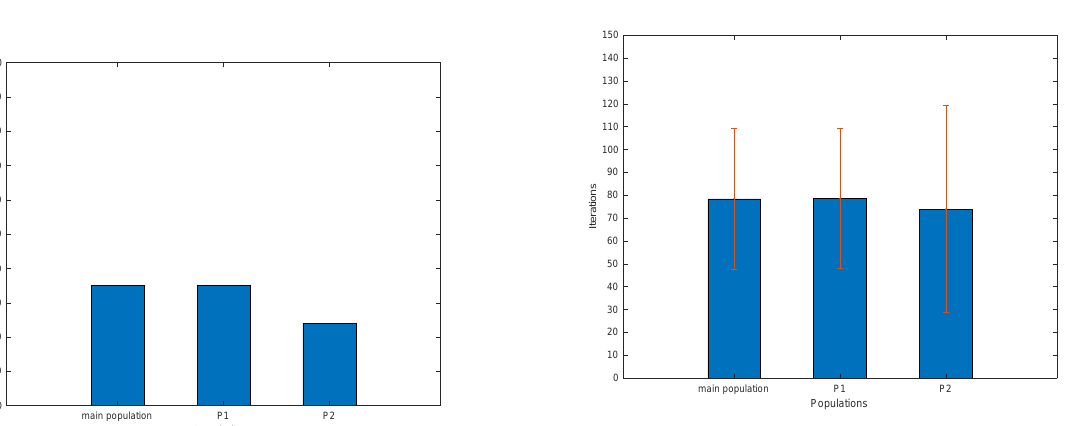
Figure 16: The figure displays the mean and the standard deviation of the average of iteration of matching to find the target object for the robot population over the 18 test images.